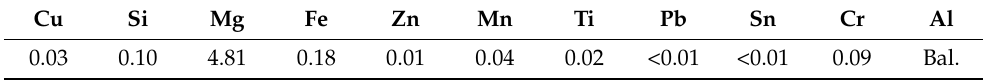
Table 2. Chemical composition of Al-4.8Mg (mass%).